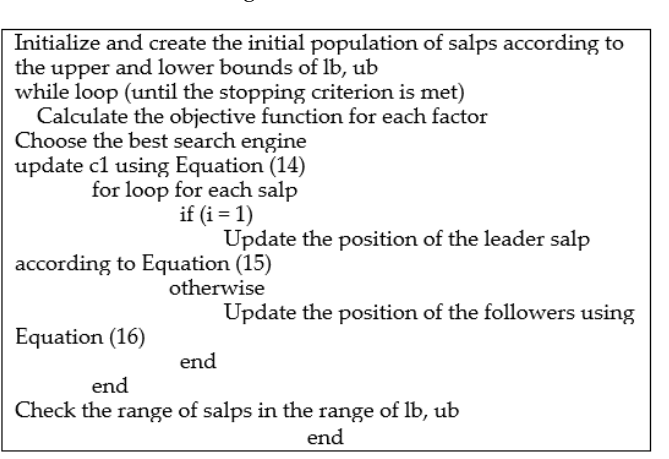
Figure 4. Pseudo code of SSA.